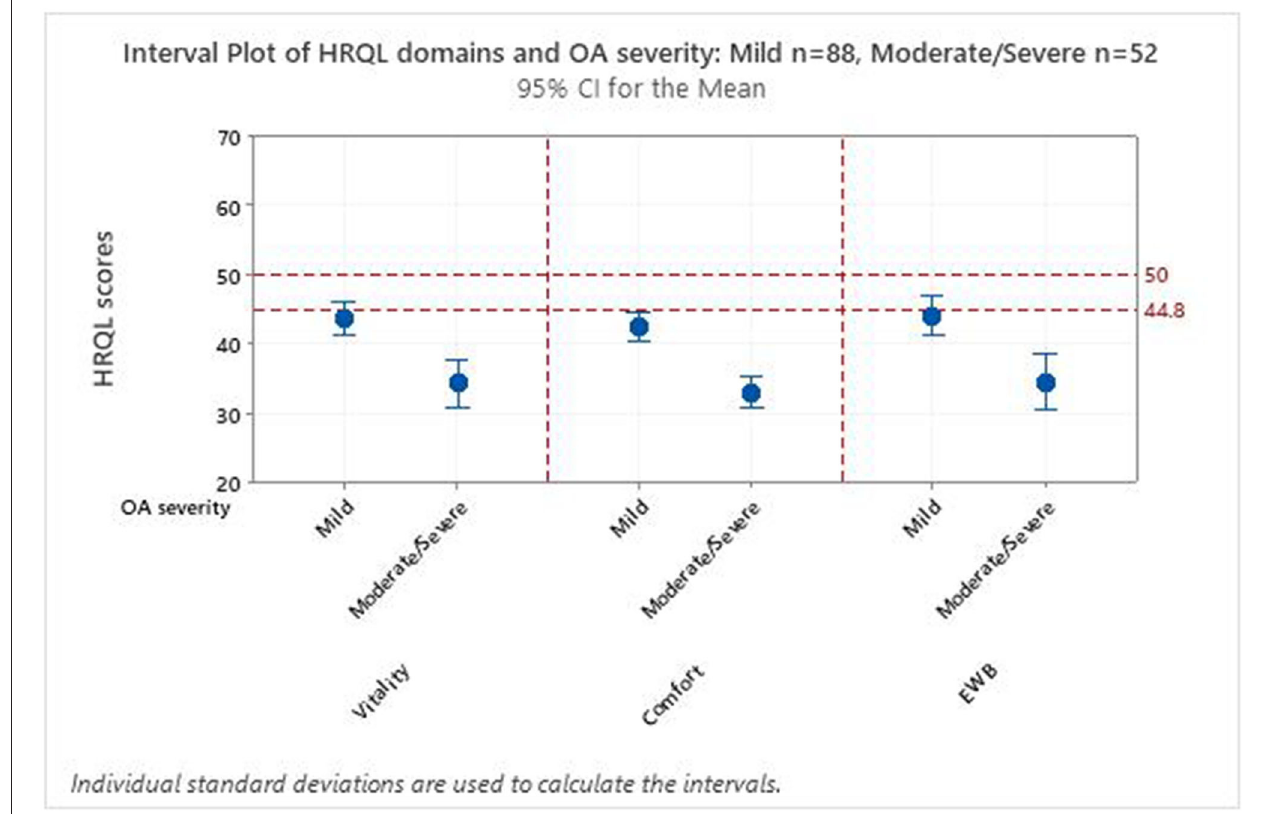
FIGURE 2 | Interval plot of the mean and confidence intervals for health-related quality of life (HRQL) scores in Vitality, Comfort and Emotional Wellbeing (EWB) domains for 140 cats with mild ( n = 88) or moderate/severe ( n = 52) osteoarthritis. The dotted line indicates the score (50) which represents the healthy population average while the broken line represents the threshold score (44.8) above which 70% of healthy cats